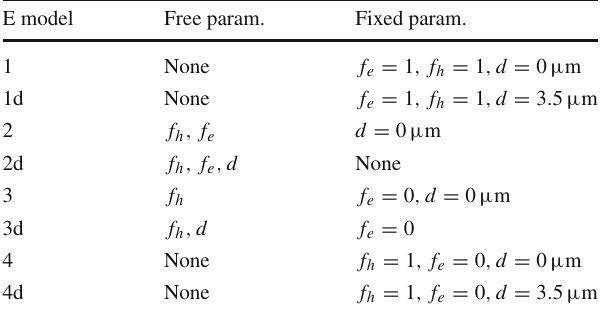
Table 3 A summary of the α energy response models studied. f e and f h are the fraction of the electron and electron-hole charge collection signals that contribute to the prompt event energy, and d is the dead layer thickness